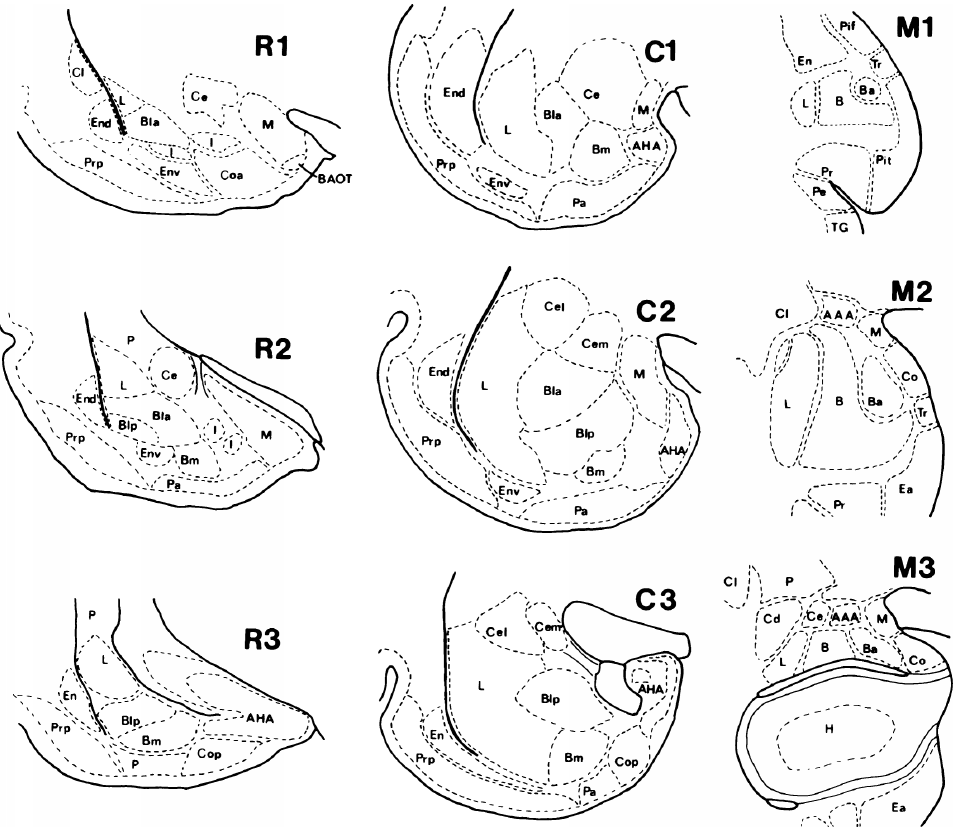
Fig. 1. Schematic illustrations of the amygdala of the rat (R), cat (C), and rhesus monkey (M) in coronal sections. For each of the three species, the amygdala is shown at an anterior (1), middle (2), and posterior (3) level. More detailed ways of subdividing some individual nuclei [magnocellular part and parvocellular part] have been omitted. Note that the drawings for the three species have not been made in the same scale. AAA = anterior amygdaloid area; AHA = amygdalo-hippocampal area; B = basal nucleus of the amygdala; Ba = basal accessory nucleus of the amygdala; BAOT = bed nucleus of the accessory olfactory tract; Bla = anterior division of the basolateral nucleus of the amygdala; Blp = posterior division of the basolateral nucleus of the amygdala; Bm = basomedial nucleus of the amygdala; Cd = caudate nucleus; Ce = central nucleus of the amygdala; Cel = lateral division of the central nucleus; Cem = medial division of the central nucleus; Cl = claustrum; Co = cortical nucleus of the amygdala; Coa = anterior division of the cortical nucleus; Cop = posterior division of the cortical nucleus; Ea = entorhinal cortex, anterior part; En = endopiriform nucleus; End = dorsal division of the endopiriform nucleus; Env = ventral division of the endopiriform nucleus; H = hippocampal formation; I = intercalated masses; L = lateral nucleus of the amygdala; M = medial nucleus of the amygdala; P = putamen; Pa = periamygdaloid cortex; Pe = perirhinal cortex; Pif = pririform cortex, frontal part; Pit = piriform cortex, temporal part; Pr = prorhinal cortex; Prp = prepiriform cortex; TG = temporal polar cortex; Tr = transition area. (After Fig. 1 of ref. 104; Copyright 1985 by the American Psychological Association. Reprinted with